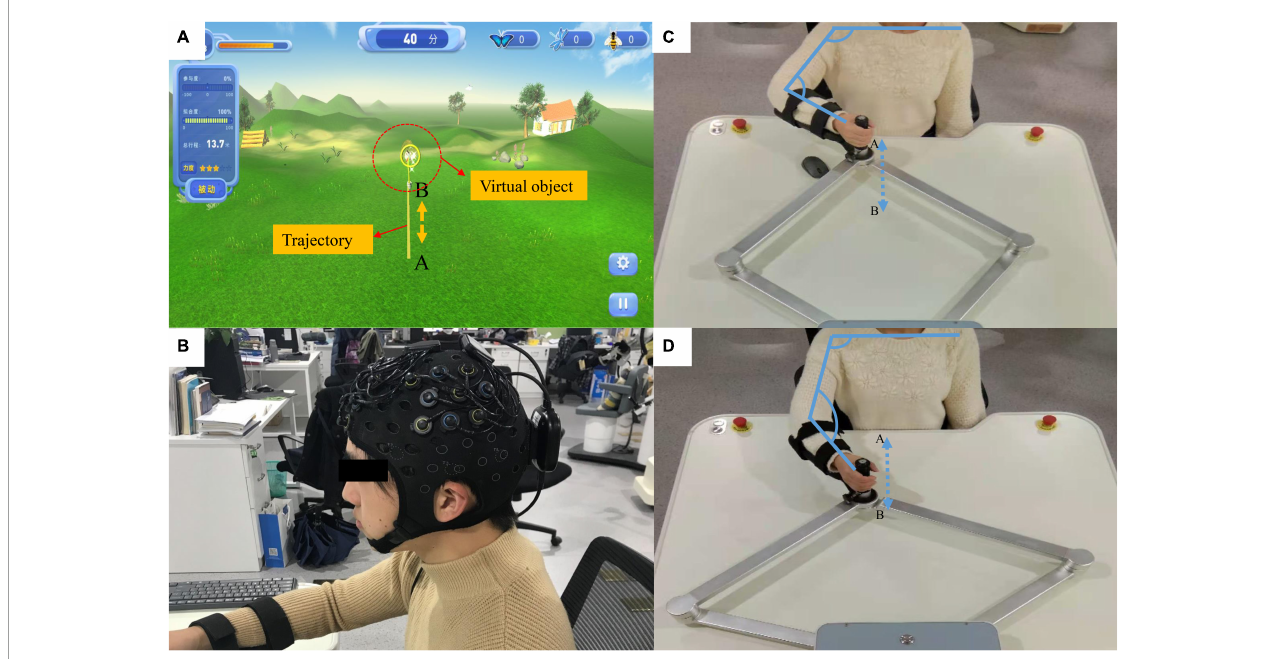
FIGURE1 Rehabilitation robots and fNIRS equipment. (A) The virtual reality (VR) system; the yellow line (from A to B) represents the training trajectory while the butterfly net represents the virtual object mapping the robot’s end effector. (B) The fNIRS equipment. (C,D) The actual movement process during the experiment. The participant’s hand was fixed onto the end effector and they carried out a straight-line reciprocating motion from A to B. The actual distance from A to B is 0.45